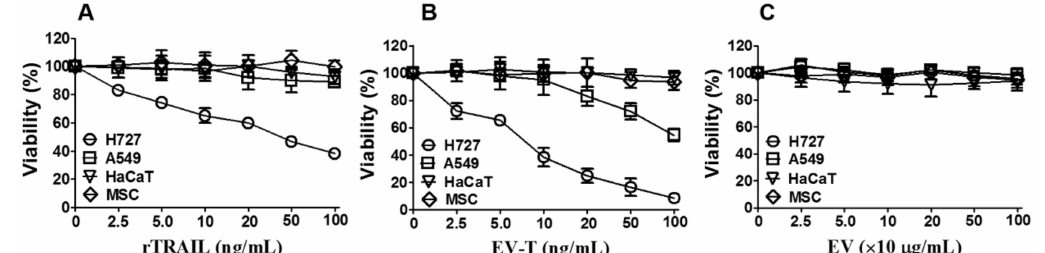
Figure 2. EV-T showed specific cytotoxicity to the highly TRAIL-resistant A549 line. Four cell lines (H727, A549, MSC and HaCaT) were treated with 2.5, 5, 10, 20, 50 and 100 ng / mL of rTRAIL ( A ), or EV-bound TRAIL (EV-T) ( B ), or EVs at indicated protein concentrations ( C ) for 24 h, respectively, followed by cell proliferation and viability assessment by Cell Counting Kit-8 (CCK-8). IC50 value for H727 and A549 lines treated by EV-T was determined as 8.1 ng / mL and 99.5 ng / mL by non-linear regression analysis, respectively. Values are mean ± S.E.M ( n =